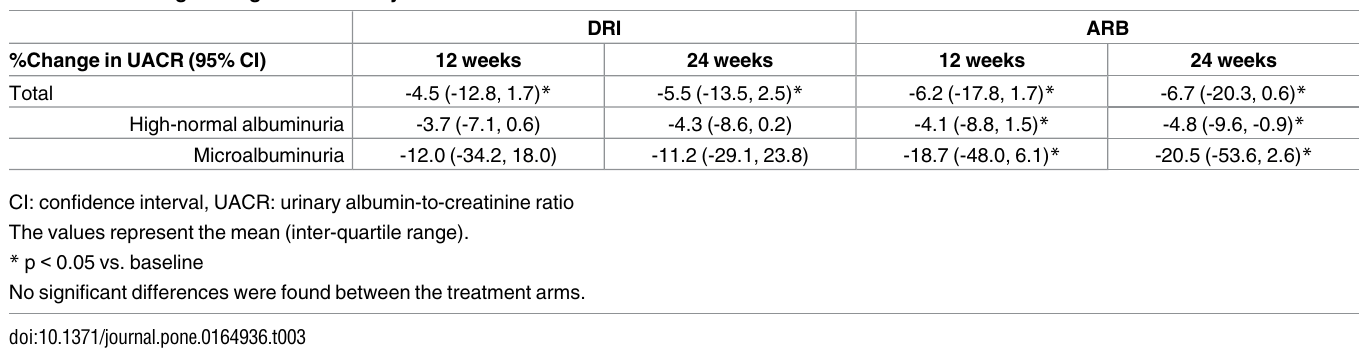
Table 3. Percentagechange in the urinary albumin-to-creatinine